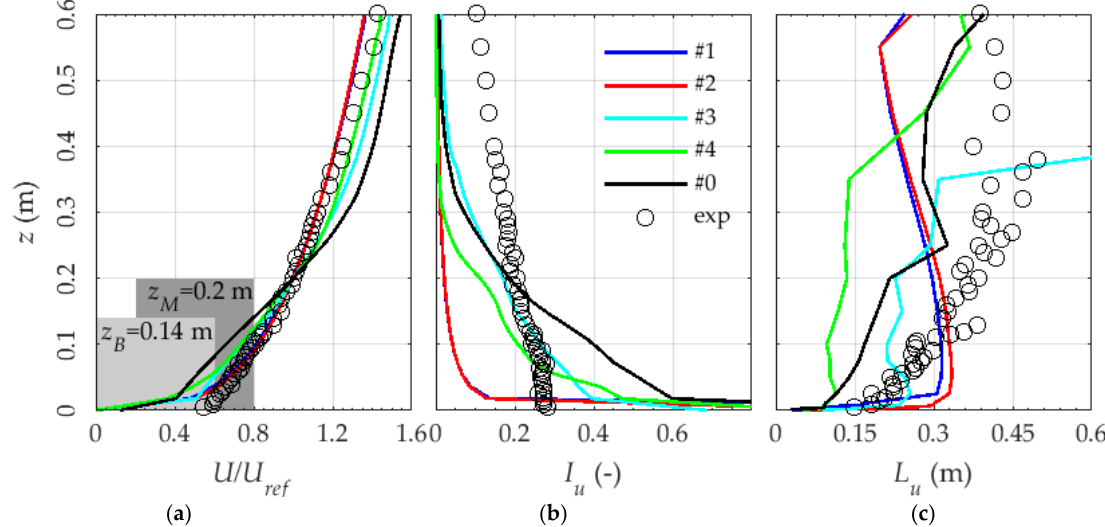
Figure 5. Inlet wind speed of the various computational domains compared with the experimental inflow. ( a ) mean wind speed; ( b ) turbulence intensity; ( c ) integral length scale of turbulence.